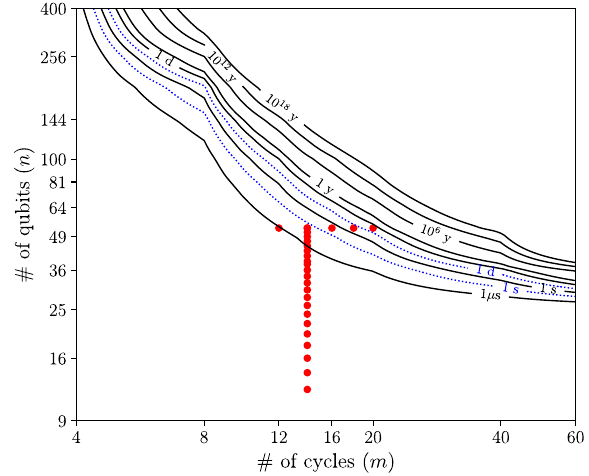
Fig. 3 Time estimates for the quantum supremacy sampling task using tensor networks and the Summit supercomputer. Black, solid contours give estimates for perfect fi delity simulations, which require only 5 bitstrings to achieve F XEB > 0 with similar con fi dence to the experiment of Ref. 1 . Blue, dotted contours consider a fi delity and a number of bitstrings similar the one achieved by the experiment of Ref. 1 for the largest circuits, i.e., n = 53 qubits and m = 20 cycles. See the main text for a discussion of both sampling